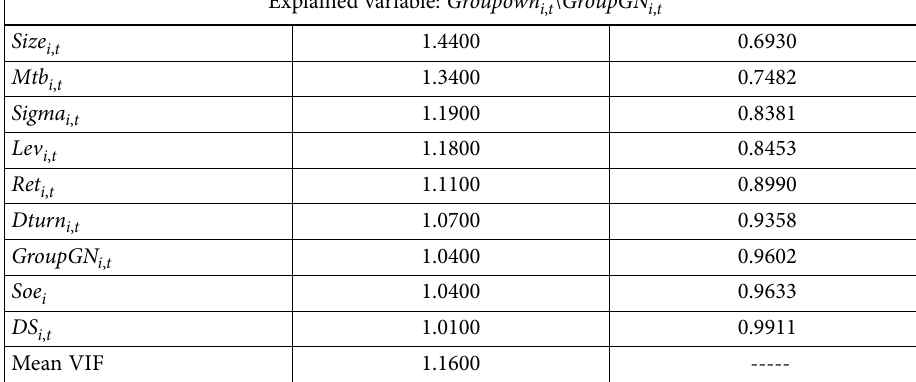
Table 3. VIF values of